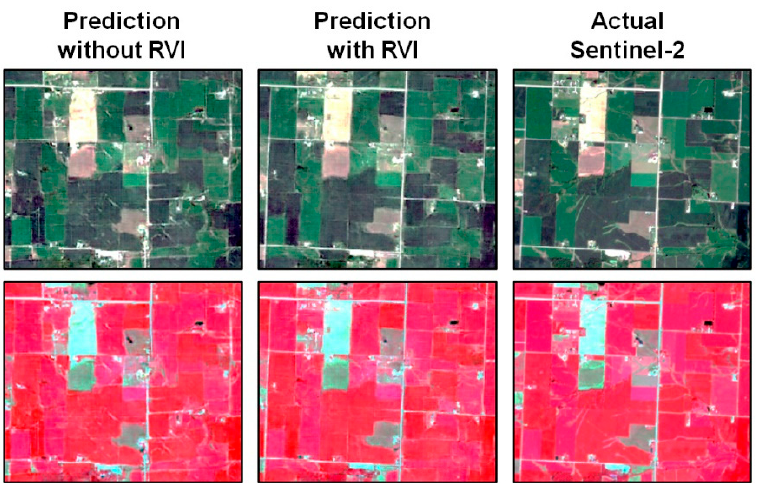
Figure 10. Comparison of prediction results for different SAR-based features with the actual Sentinel-2 imagery. The first and second rows represent the true and false color composite (NIR-red-green as RGB) images, respectively.